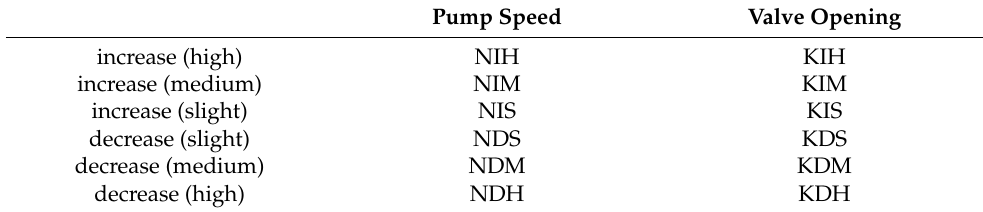
Table 1. Linguistic variables of the controller output.